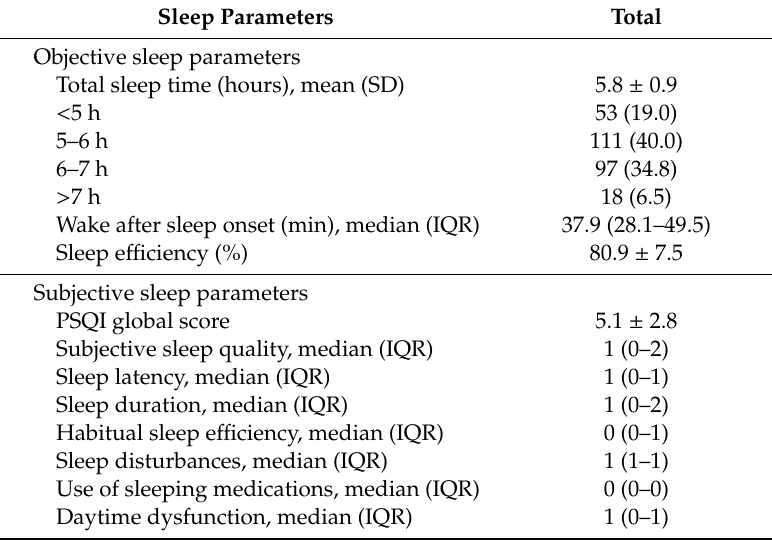
Table 2. Distribution of objective and subjective sleep